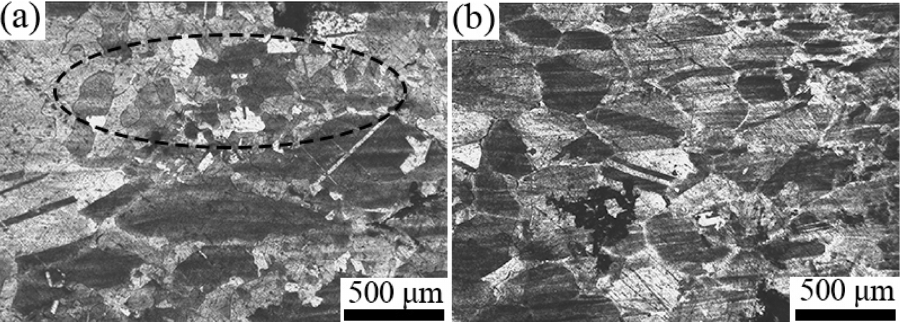
Figure 4: The microstructure of the longitudinal sections near the fracture front of alloy B0 (a) and B1 (b) specimens strained at